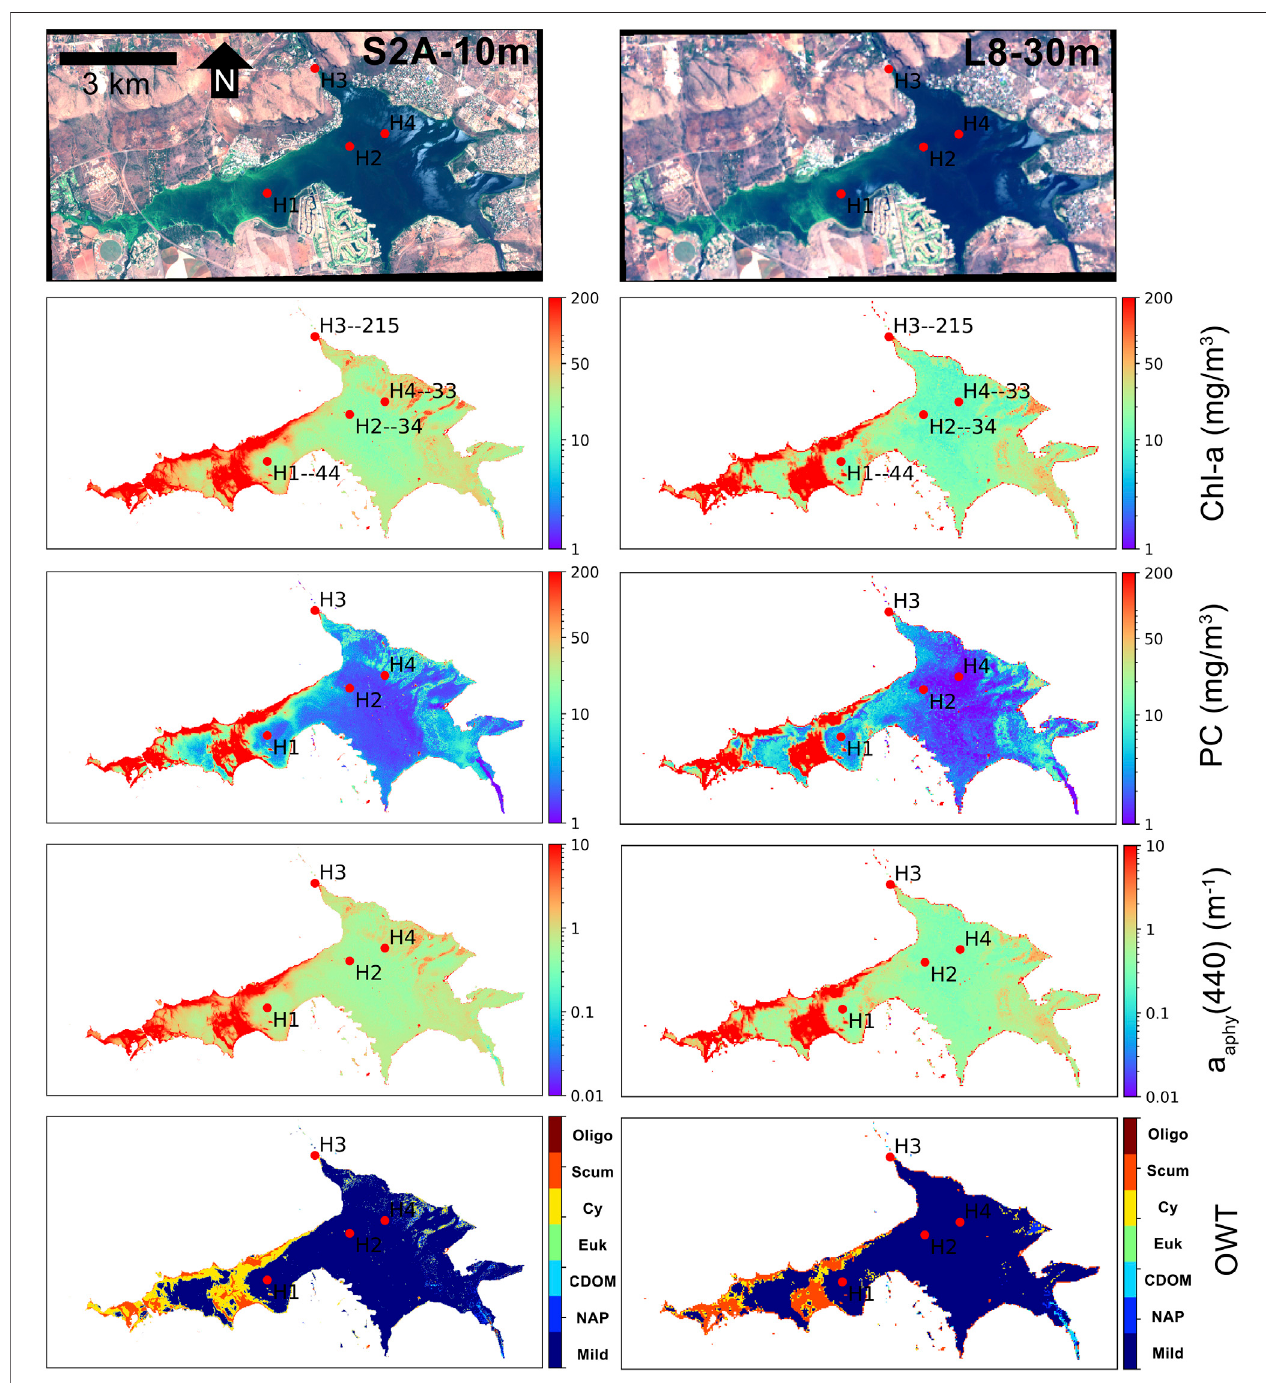
FIGURE 7 | MLP product retrievals over Hartbeespoort Dam on October 27, 2016. The left column shows retrievals using S2 10 m con fi guration while the right column is the L8 retrievals. All products are derived from TOA re fl ectance. On the chl-a panels, in-situ sampling points (red dots) are labeled with the station name followedbythemeasuredquantityofchl-a,inunitsofmg/m 3 (e.g.,H1--44indicatesstationH1withameasured in-situ chl-aconcentrationof44 mg/m 3 ). In-situ dataare from Kravitz et al.